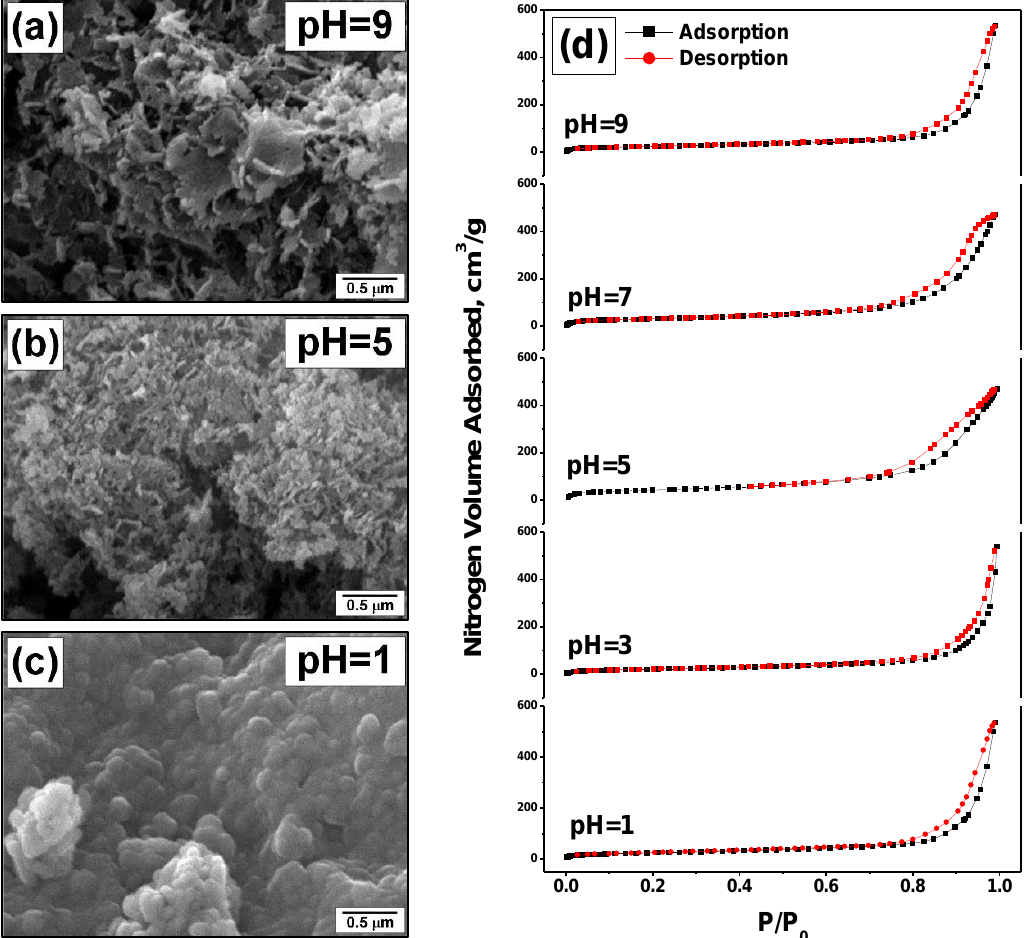
Figure 2. Characterization of the Ni-Mg-O samples obtained at various pH: ( a – c ) scanning electron microscopy images; ( d ) low-temperature nitrogen adsorption/desorption isotherms.